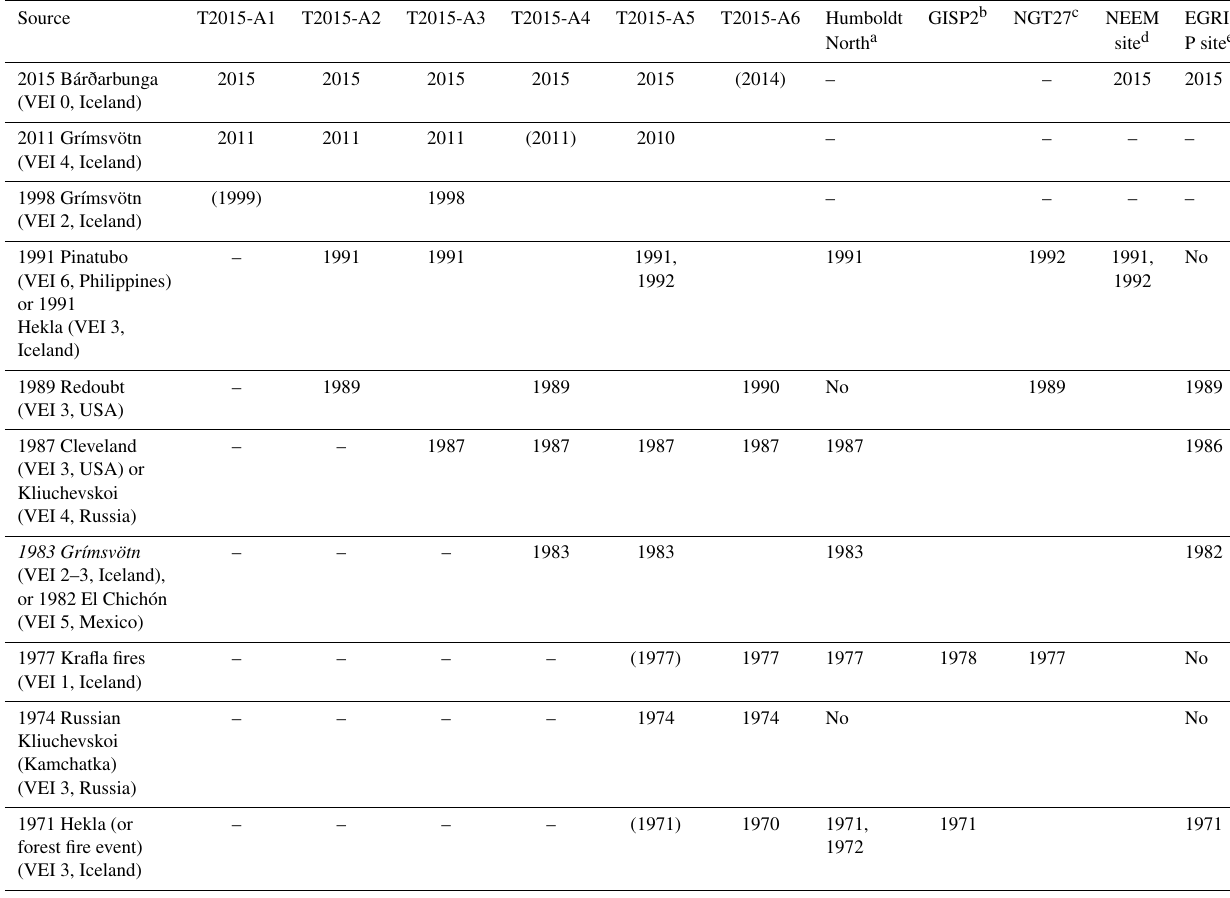
Table 3. A list of volcanic eruptions covered in this study, presented as a suggestion of the volcanic sources of the years where excess acidity or excess conductivity as compared to a 5-year running average exceed the 97.5% quantile in each of the six shallow cores. In addition, other shallow cores with similar excess acid, conductivity or sulfate are shown. Dashes indicate where data are not available. Years in parentheses indicate that (while there is an increase compared to background levels) the data do not exceed the 97.5%